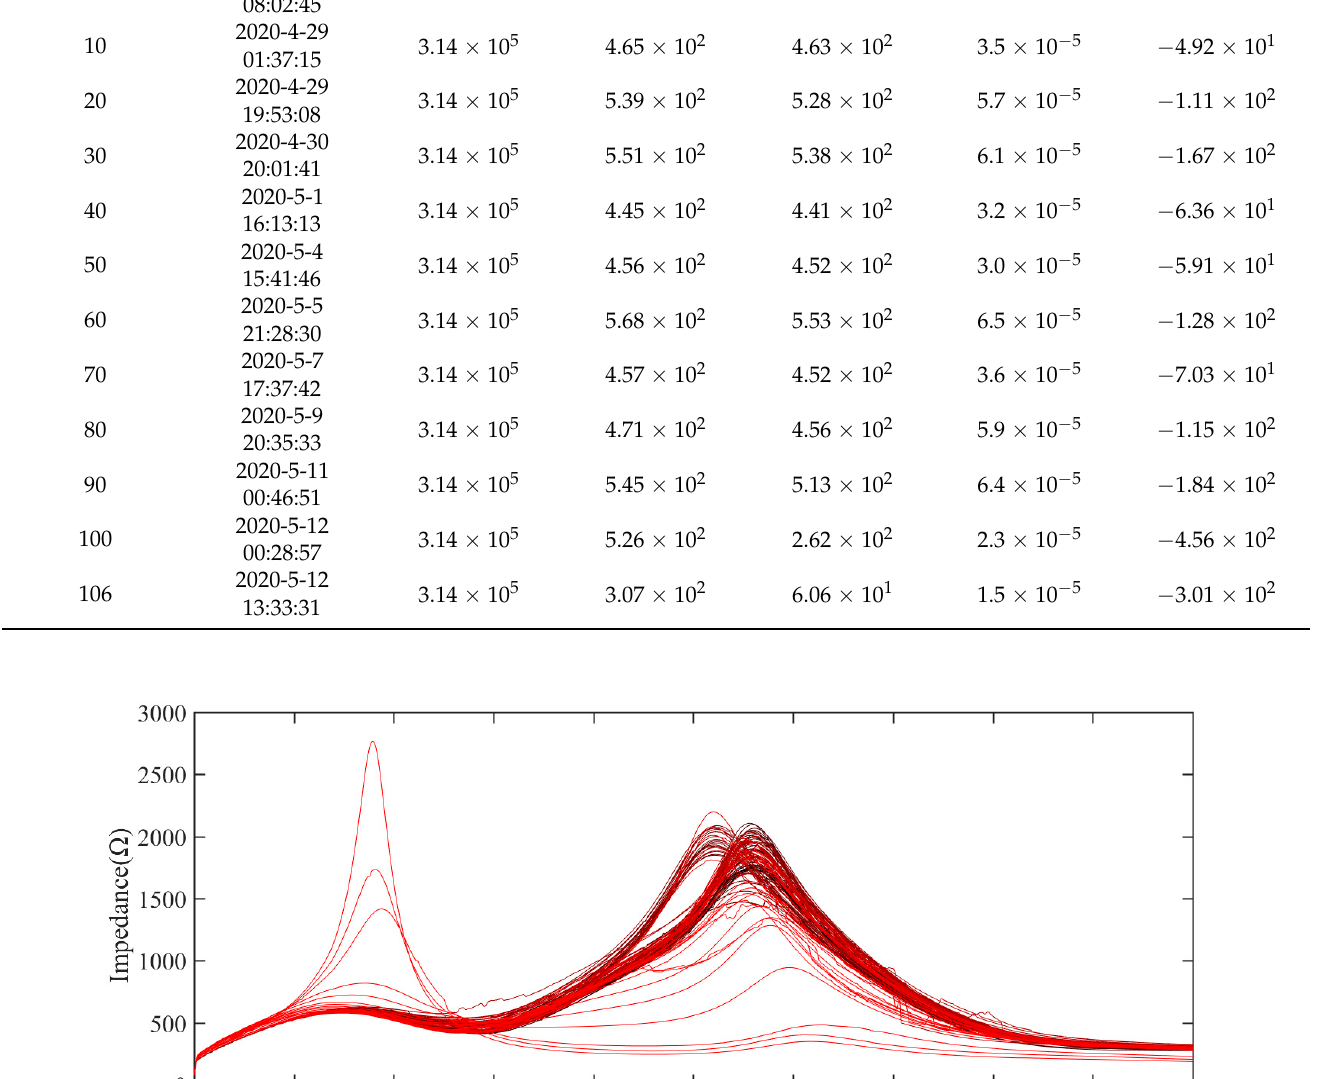
Figure 5. The measurement value of resistance spectra of the electromagnetic coil in the whole life. Figure 6. The measurement value of inductance spectra of the electromagnetic coil in the whole life.